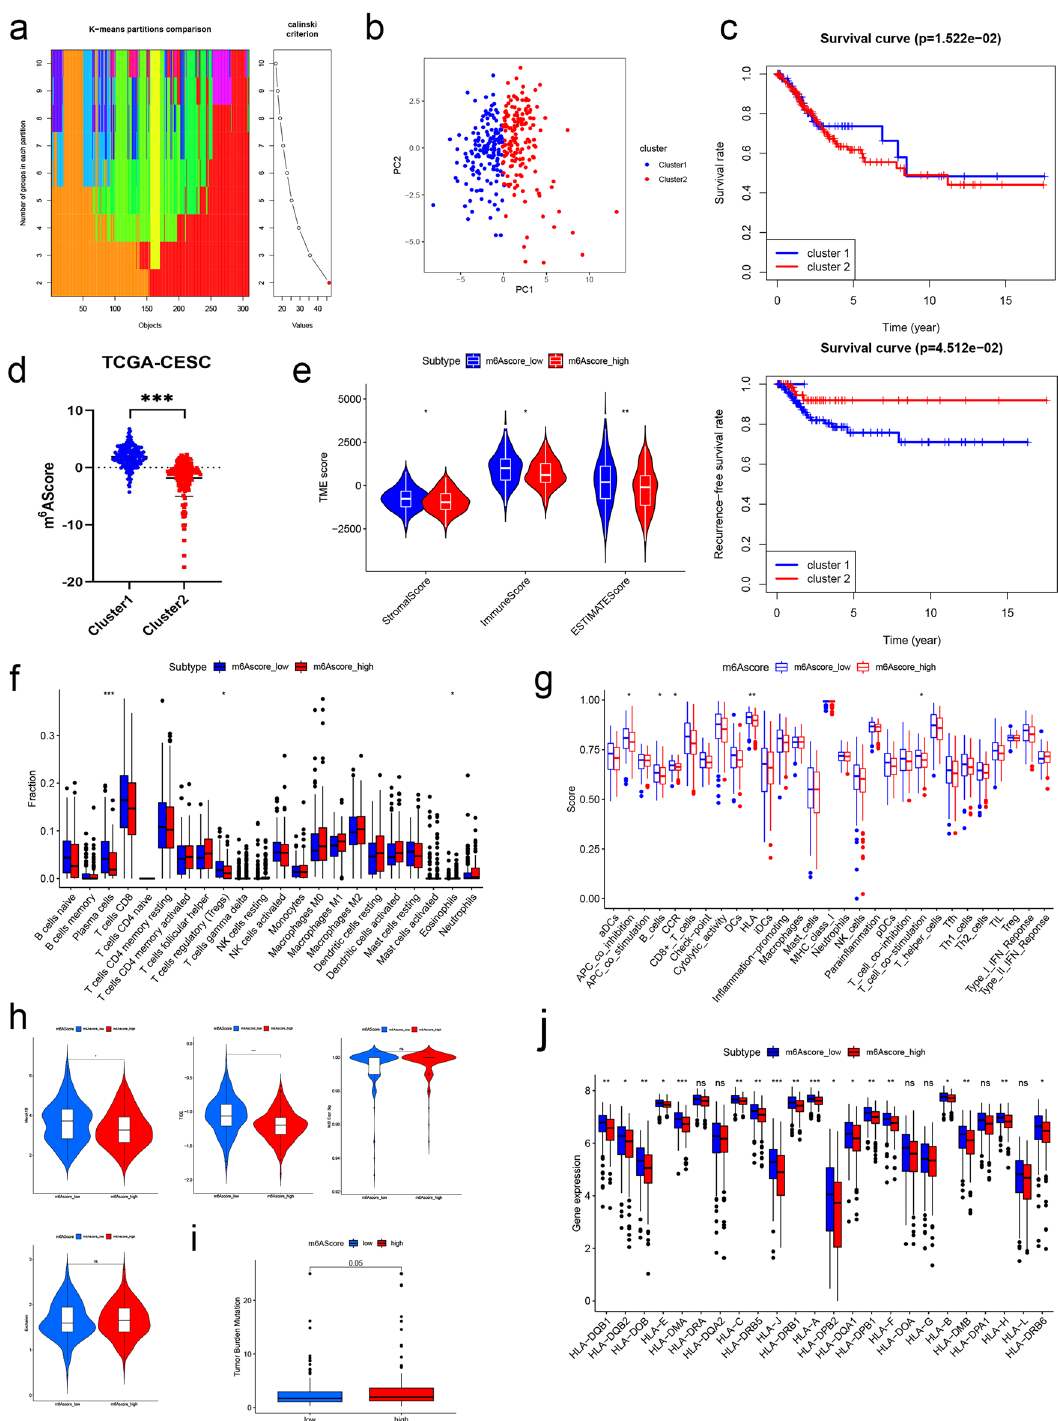
Figure 5. Identification and characteristic description of consensus clustering. ( a,b ) Consensus clustering for k = 2 based on m 6 A regulators ( a ) and visualization by PCA plot ( b ). ( c ) Kaplan–Meier survival curves for patients in different subgroups, OS and RFS. ( d ) Representation of the groups character by m 6 AScore. ( e ) Analysis and comparison of tumor microenvironment in patients with different m 6 AScore level. ( f ) The comparison of proportion of 22 immune cells in 309 patients of different m 6 AScore group. ( g ) Immune function analysis and comparison in patients with different m 6 AScore group. ( h ) Immune escape analysis (Merck18, TIDE, MSI score and T cell Exclusion) and comparison in patients with different m 6 AScore level. ( i ) Tumor mutation burden between different m 6 AScore and TMB. ( j ) Box plot showed the comparison of HLA family genes expression between different m 6 AScore groups. * P < 0.05; ** P < 0.01; *** P < 0.001; **** P <